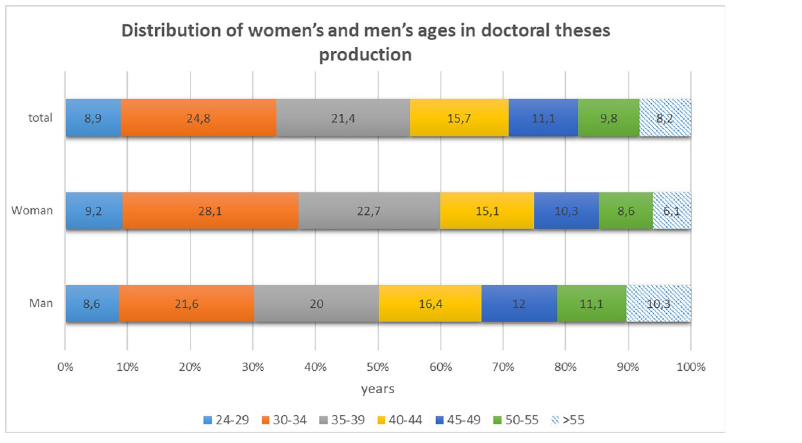
Fig 1. Author’s age and gender distribution.